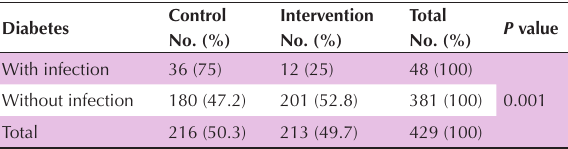
Table 6. Incidence of cesarean section infection by diabetes of mothers Control Diabetes No. (%)